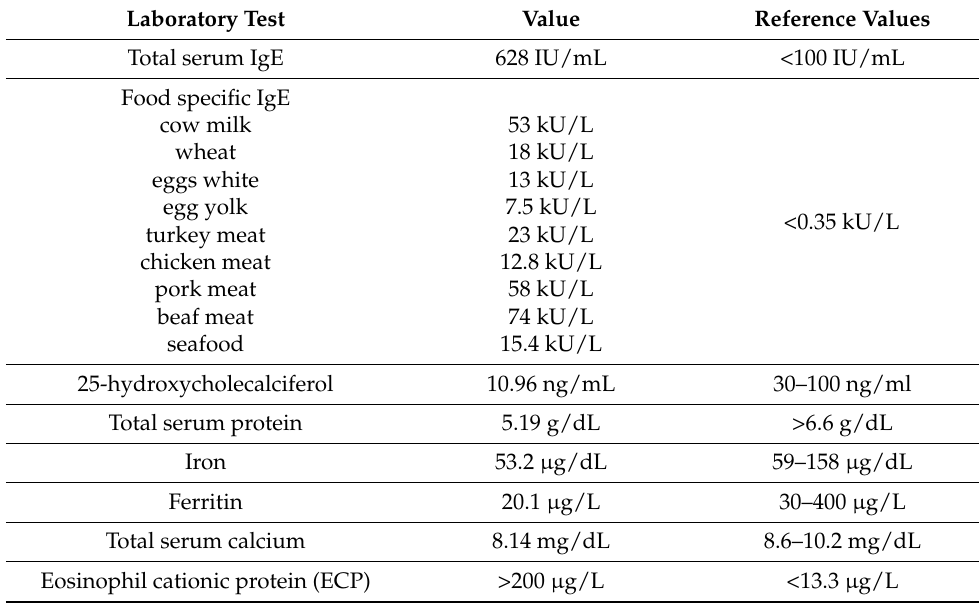
Table 1. Abnormal laboratory tests at EGE diagnosis (2017).